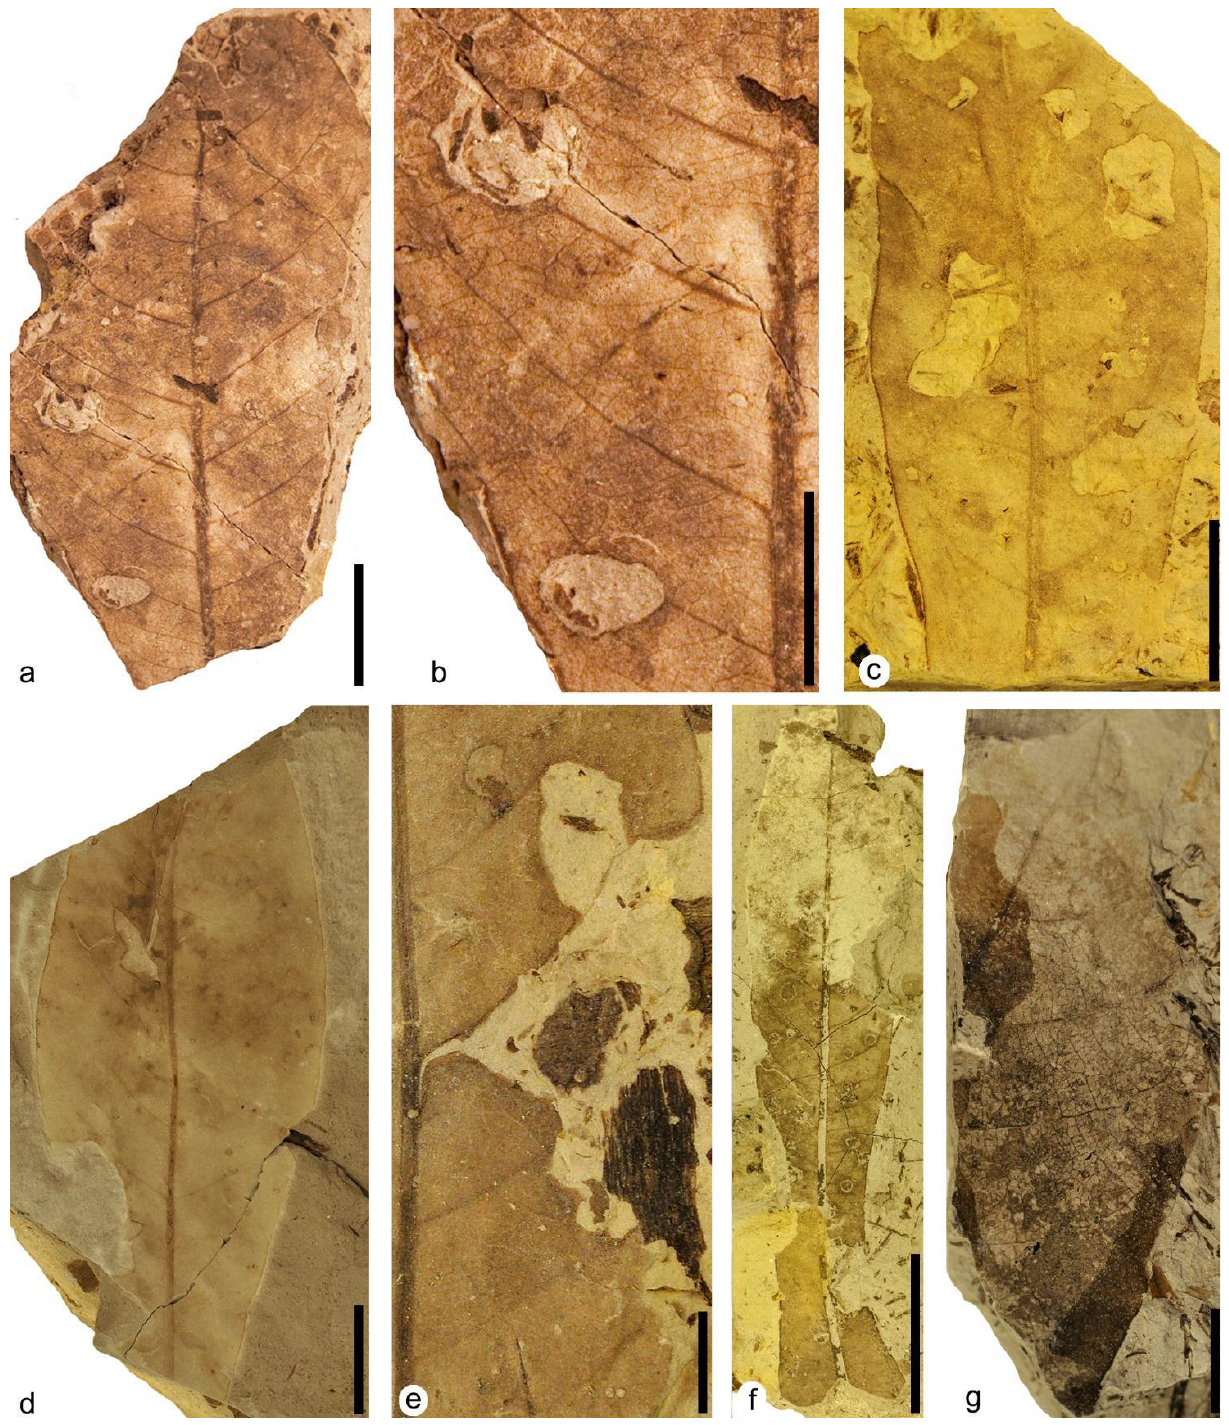
Figure 6. Plant – insect interactions on leaves of the terrestrial Angiosperm Type 1. ( a ) MAP-8362, fragment of a big leaf with hole feeding DT03 and DT04. ( b ) Detail of big holes of hole feeding DT03 and DT04 in photo (a). ( c ) MAP-8363, middle part of a leaf with hole feeding DT03, DT05 and margin feeding DT13. ( d ) MAP-8364, central part of leaf with hole feeding DT05, margin feeding DT14 and piercing and sucking DT46. ( e ) Detail of the right margin in the central area of the leaf in Figure 5a corresponding to MAP-8359 with margin feeding DT15. ( f ) MAP-8365, a nearly complete big leaf with skeletonization DT16 and galling DT120 bearing several galls distributed randomly on its surface. ( g ) MAP-8366, fragment of leaf with skeletonization DT17. Scale bars: ( a , c , d , f ) = 2 cm; ( b , e , g ) = 1